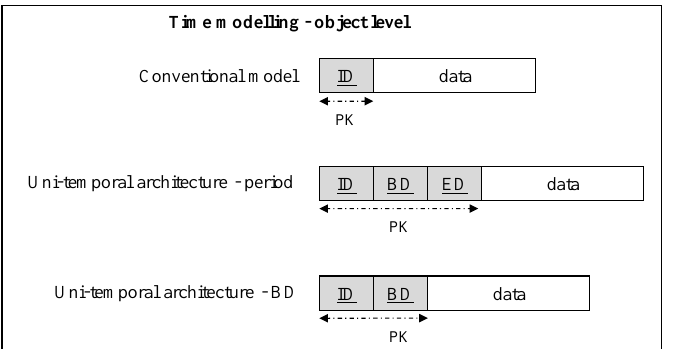
Figure 4. Object-level temporal architecture.